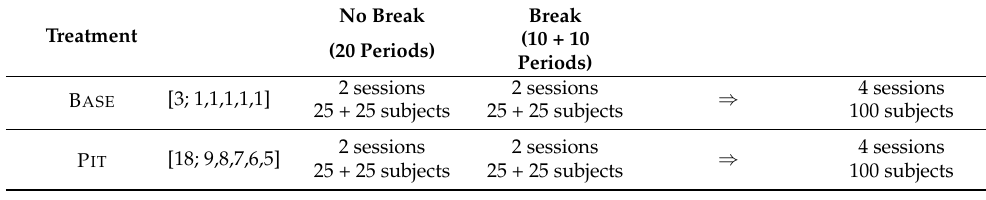
Table 1. Treatment Conditions, Sessions and Subjects.